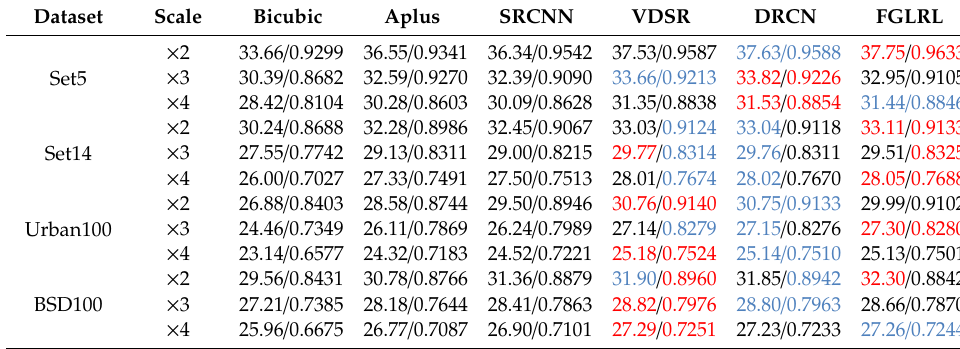
Table 1. Comparison of peak signal-to-noise ratio (PSNR) and structural similarity index (SSIM) values for various methods with a scale of × 2, × 3, × 4 on Set5, Set14, Urban100, BSD100.